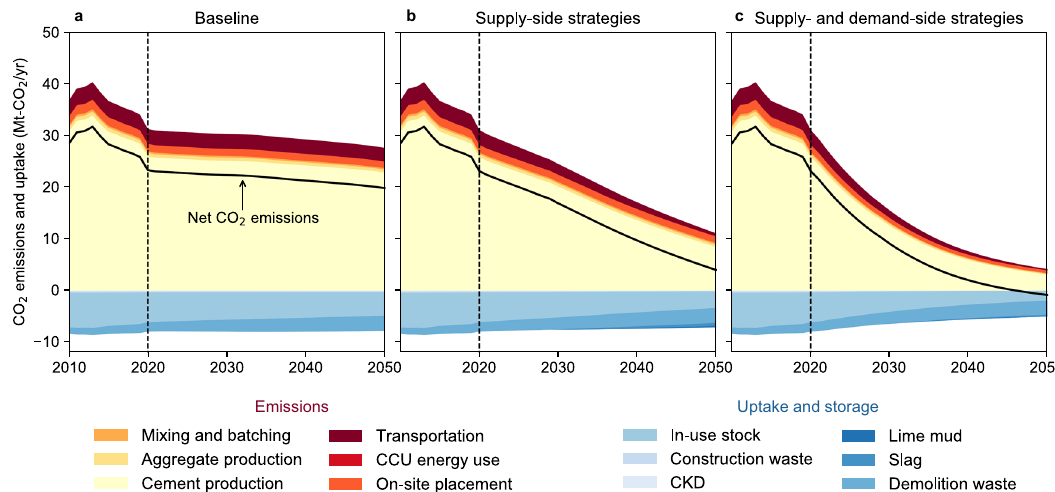
Fig. 4 CO 2 emission and uptake associated with cement and concrete cycle in Japan under the three representative scenarios, 2010 – 2050. a Baseline. b Supple-side strategies. c Supple- and demand-side strategies. The vertical dashed lines mark the year in which the future scenarios begin (2020). CCU carbon capture and utilization, CKD cement kiln dust.